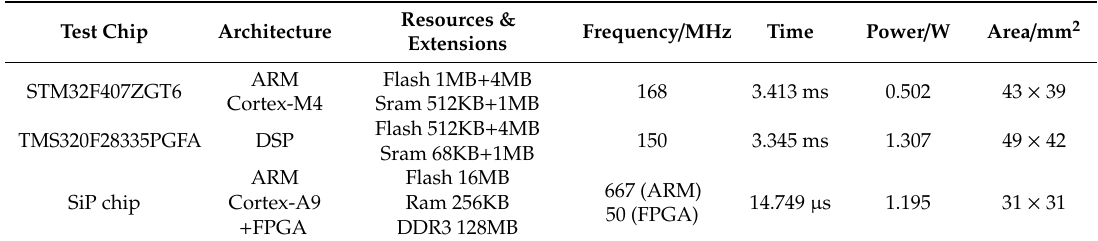
Table 6. Aviation computer comparison test form.